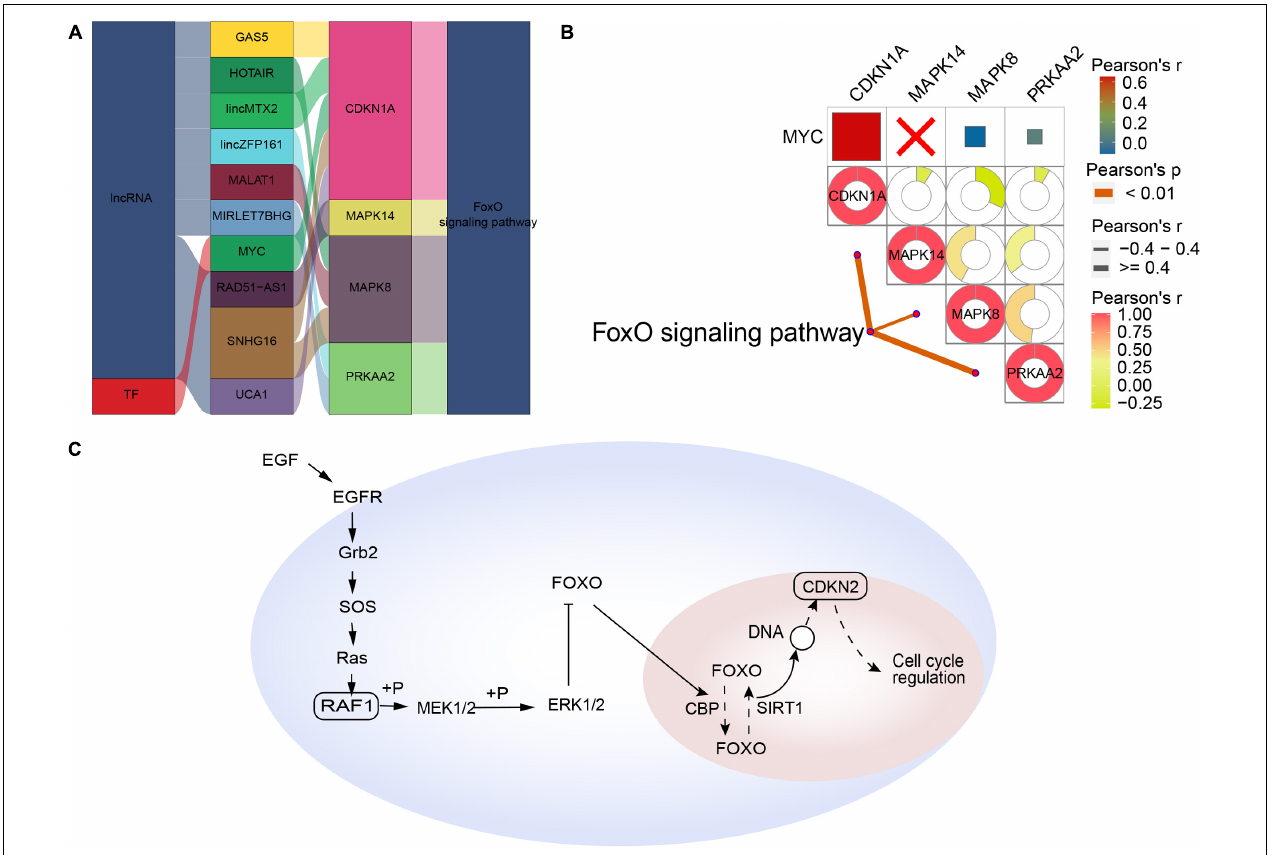
FIGURE 5 | Potential regulatory mechanism of forkhead box class O (FoxO)-type Alzheimer’s disease (AD). (A) Sankey diagram showing the pathway of FoxO-type AD regulated by long non-coding RNAs (lncRNAs) and transcription factors (TFs) identified by the RNAInter and TRRUST databases. (B) Correlation pathway diagram of the gene–pathway, gene–gene, and TF–gene correlations. (C) Potential regulatory mechanism of FoxO-type